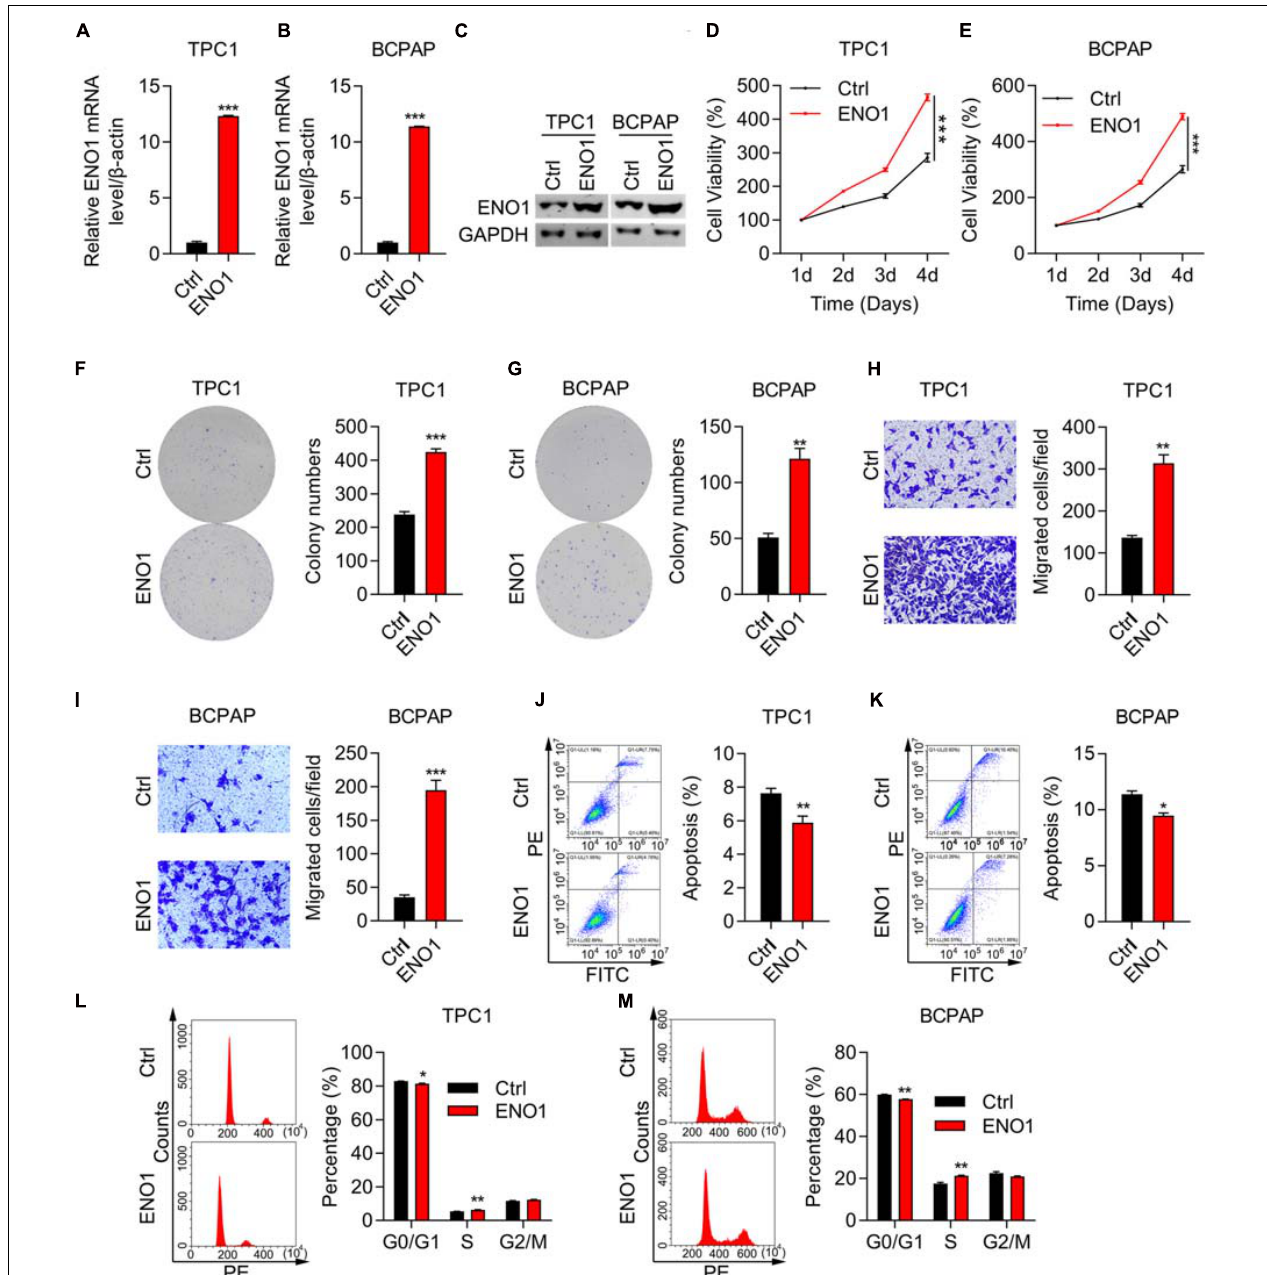
FIGURE 4 | ENO1 overexpression promotes proliferation and invasion and inhibits apoptosis. (A,B) qRT-PCR analysis of ENO1 overexpression in TPC1 (A) and BCPAP (B) cells. β -actin was used for normalization, *** P < 0.001. (C) Western blotting analysis of ENO1 overexpression in TPC1 and BCPAP cells. GAPDH was used as a loading control. (D,E) CCK8 cell viability analysis of control or ENO1-overexpressed TPC1 (D) and BCPAP (E) cells, *** P < 0.001. (F,G) Colony formation assay of control or ENO1-overexpressed TPC1 (F) and BCPAP (G) cells. ** P < 0.01, *** P < 0.001. (H,I) Transwell invasion analysis of control or ENO1-overexpressed TPC1 (H) and BCPAP (I) cells. *** P < 0.001, ** P < 0.01. (J,K) Flow cytometry analysis of apoptosis using Annexin V-FITC and PI staining in control or ENO1-overexpressed TPC1 (J) and BCPAP (K) cells. * P < 0.05, ** P < 0.01. (L,M) Cell cycle was measured using PI staining and flow cytometry in control or ENO1-overexpressed TPC1 (L) and BCPAP (M) cells, * P < 0.05, ** P <